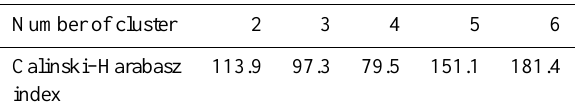
Table 1. Summary of cluster